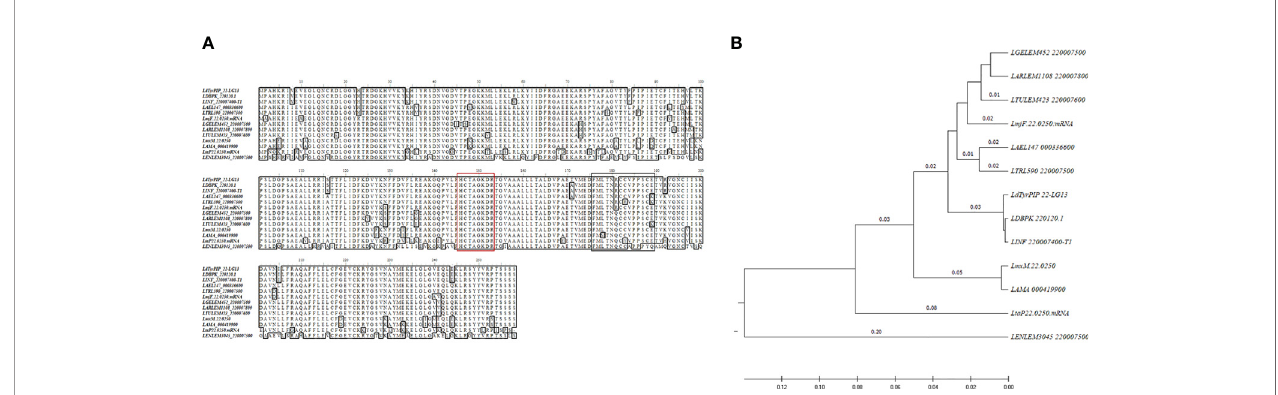
FIGURE 1 | Sequence comparison of the Ld TyrPIP_22 orthologs in Leishmania spp. (A) ClustalW multiple sequence alignment of the ldtyrpip_ 22 gene product orthologs in Leishmania spp. The L. donovani (strain LG13, MHOM/ET/0000/HUSSEN) Ld TyrPIP_22 aa sequence (GenBank ® accession No MF461274) was generated in this work. The aa sequences for the L. donovani LdBPK_220120.1 gene product from the Nepalese strain BPK282A1 and from another eleven Leishmania spp. ( Table S2 ) with genomes sequenced were obtained from the TriTrypDB database and were analyzed/edited using the software BioEdit Sequence Alignment Editor. The aa of the PTP P-loop motif are framed by a red box; The aa predicted as S-Palmitoylation site are framed by the black box. (B) Rooted phylogenetic tree (UPGMA) from a multiple sequence alignment of the Ld TyrPIP_22 orthologs from Leishmania